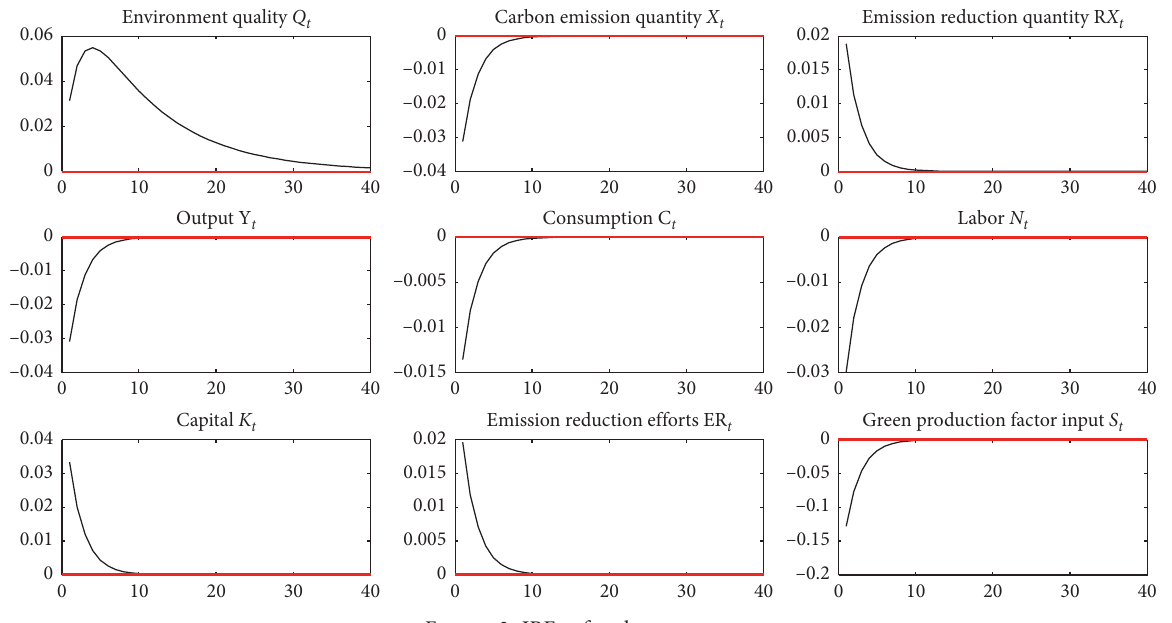
Figure 3: IRFs of carbon tax